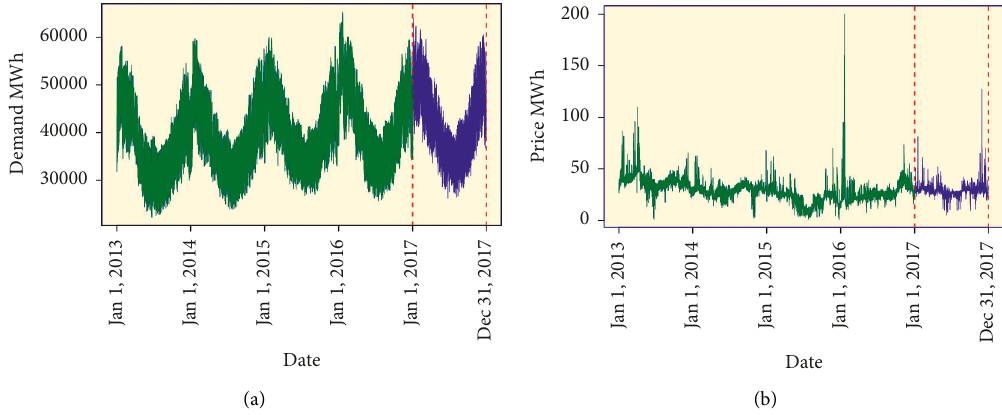
Figure 3: Nord Pool electricity data: demand (a) and prices (b) over the period of January 1, 2013 to December 31, 2017. The out-of-sample forecasting period is separated by two vertical